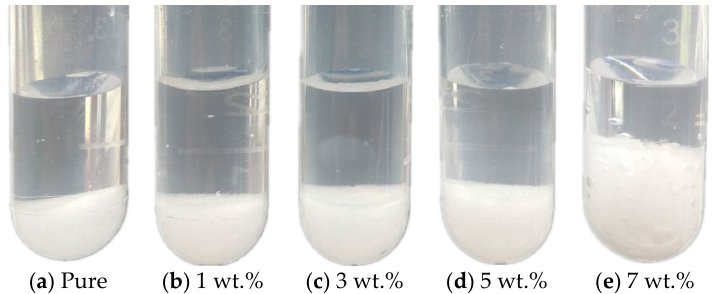
Figure 3. Photographs of the Na 2 SO 4 ·10H 2 O–KCl eutectics containing different mass fractions of KCl: ( a – e ) 0–7 wt.%.